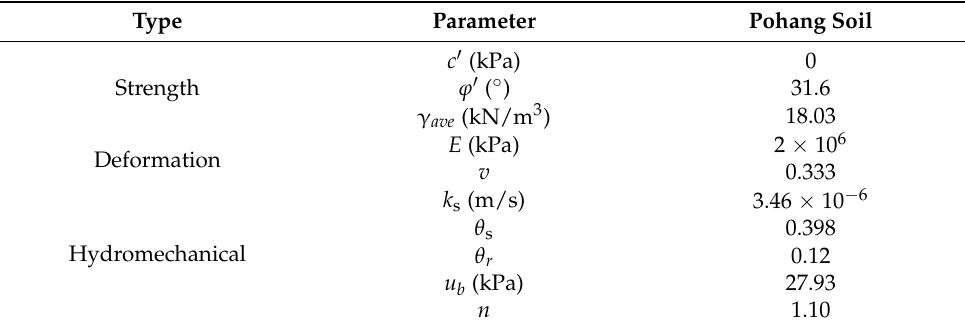
Table 2. Geotechnical and hydromechanical properties of Pohang soil [21].